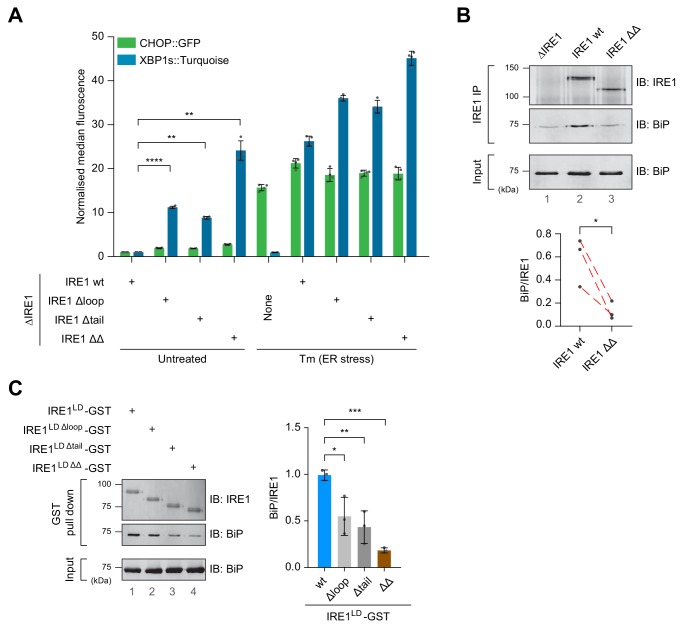
Cells expressing IRE1LD deletion variants exhibit a de-repressed IRE1 phenotype that correlates with less BiP bound to IRE1.(A) Bar diagram of median XBP1::Turquoise and CHOP::GFP signals from untreated and tunicamycin (Tm)-treated CHO-K1 dual UPR reporter cells with Ern1 alleles encoding wild-type (wt) or the indicated deletion variants of IRE1 (∆loop, missing residues 313–338, ∆tail, missing residues 391–444, or ∆∆, missing both). Data from four independent experiments is shown [mean ± standard deviation (SD), **: p<0.01, ****: p<0.0001, one-way ANOVA with Sidak’s multiple comparison test] (Figure 4—source data 1). (B) Representative immunoblot (IB) of endogenously-expressed wt or the IRE1 ∆∆ deletion mutant (see ‘A’) and associated BiP recovered by immunoprecipitation (IP) of IRE1. BiP in input cell lysates is provided as a loading control. Quantification of the ratio of BiP to IRE1 signals after IP of three independent experiments is shown below (mean ± SD, *: p<0.05, ratio paired parametric Student’s t test) (see: Figure 4—source data 2) (C) Left panel shows a representative immunoblot of the indicated IRE1 variants with glutathione S-transferase (GST) replacing the cytosolic domain. The proteins were introduced into CHO-K1 cells by transient transfection, and the associated endogenous BiP recovered by glutathione pull down. BiP in input cell lysates is provided as a loading control. Quantification of the ratio of BiP to IRE1 signals in the IP of three independent experiments is shown to the right (mean ± SD, *: p<0.05, **: p<0.01, ***: p<0.001, one-way ANOVA with Sidak’s multiple comparison test).Figure 4—source data 1.Source data for Figure 4A.Figure 4—source data 2.Source data for Figure 4B.